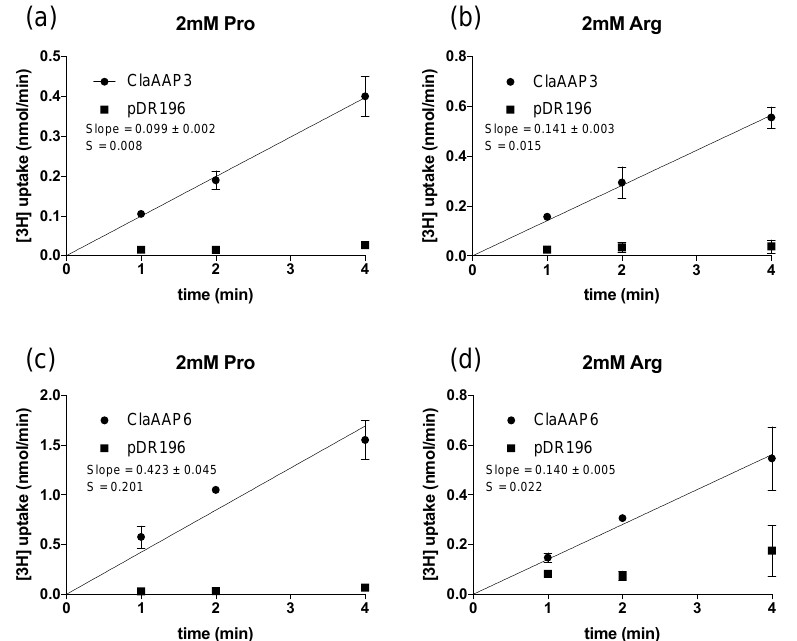
Figure 3. Uptake of [ 3 H] labeled amino acids by yeast 22 ∆ 10 α cells. ( a , b ) Time-dependent uptake of [ 3 H]Pro ( a ) or [ 3 H]Arg ( b ) into the cells expressing ClaAAP3 (circles) or empty vector (squares). ( c , d ) Time-dependent uptake of [ 3 H]Pro ( c ) or [ 3 H]Arg ( d ) into the cells expressing ClaAAP6 (circles) or empty vector (squares). The uptake of [ 3 H]-labeled amino acids was measured at 2 mM concentration. Each data point represents three biological replicates. Error bars represent standard deviation ( n = 3). The standard error of the regression (S) is shown for each linear fit.